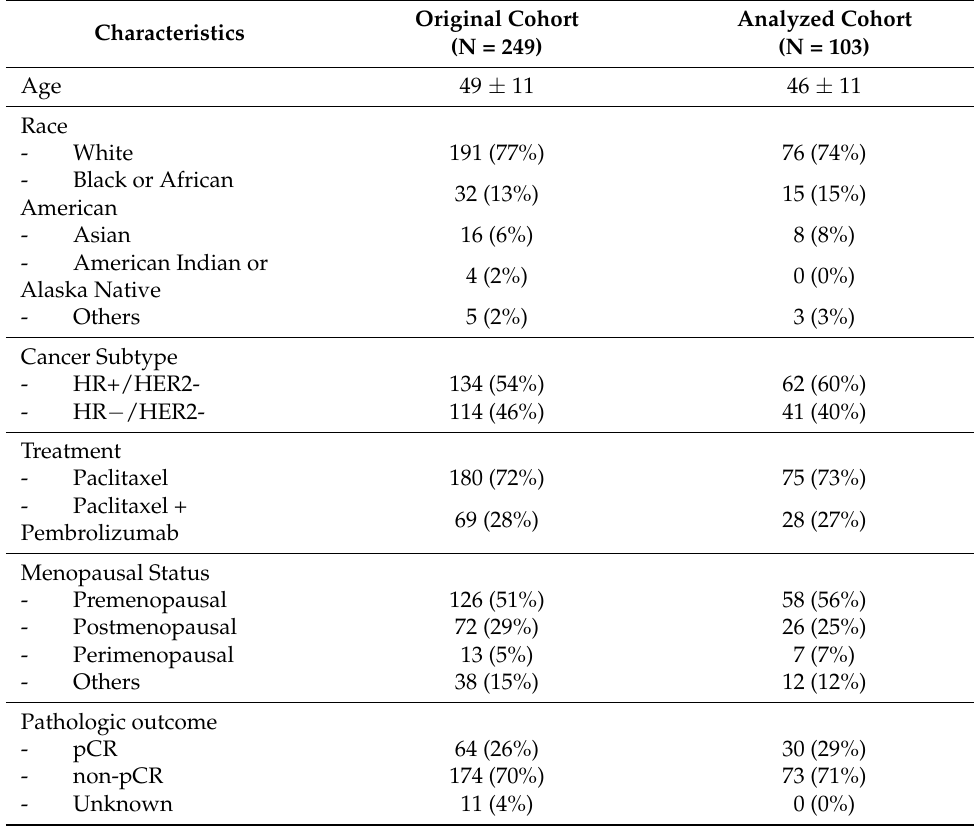
Table 2. Patient